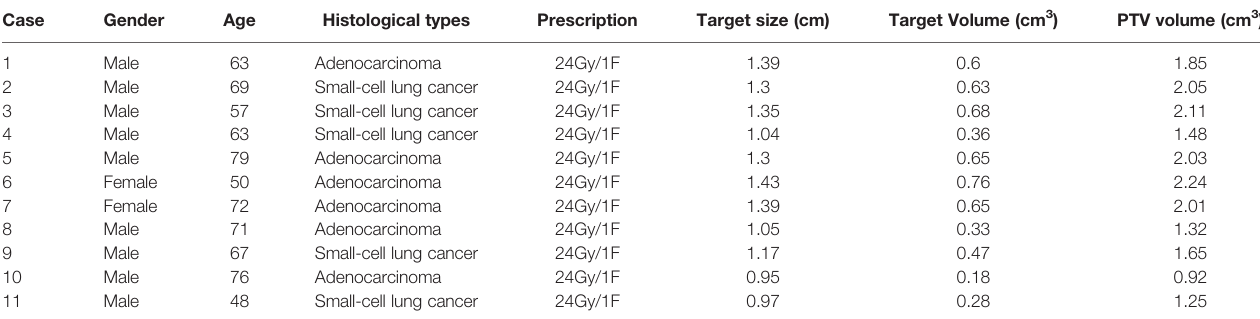
TABLE 1 | Characteristics of enrolled